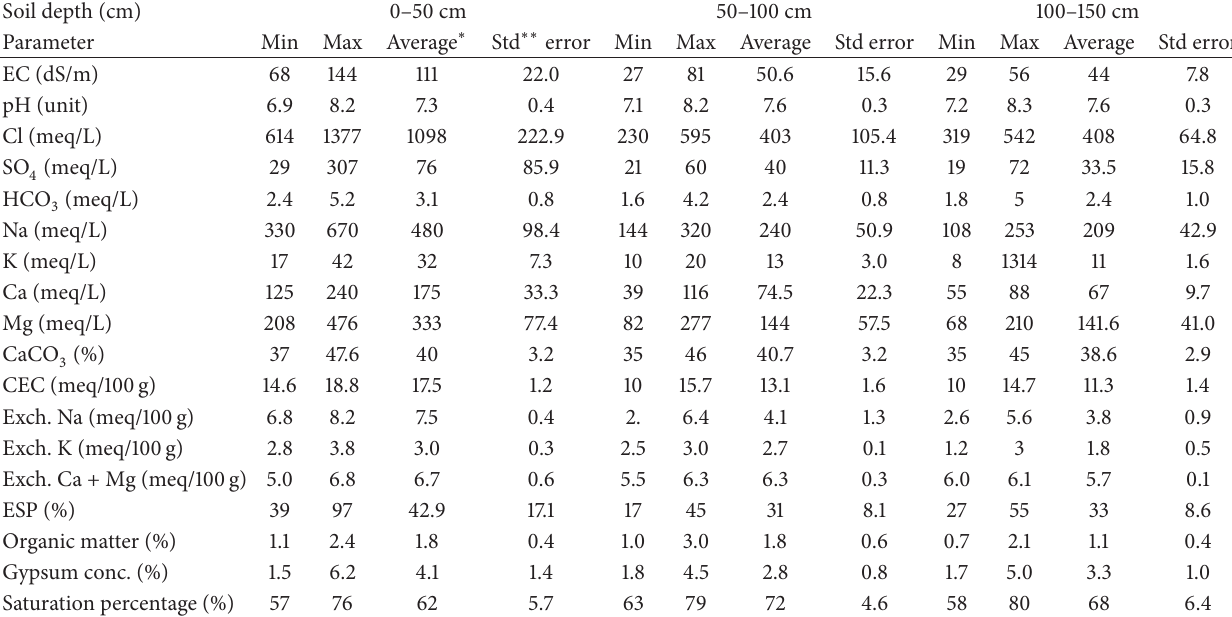
Table 1: Chemical properties of the soil before starting the leaching experiment (minimum, maximum, average, and standard error). Soil depth (cm) 0–50 cm 50–100 cm 100–150 cm Parameter